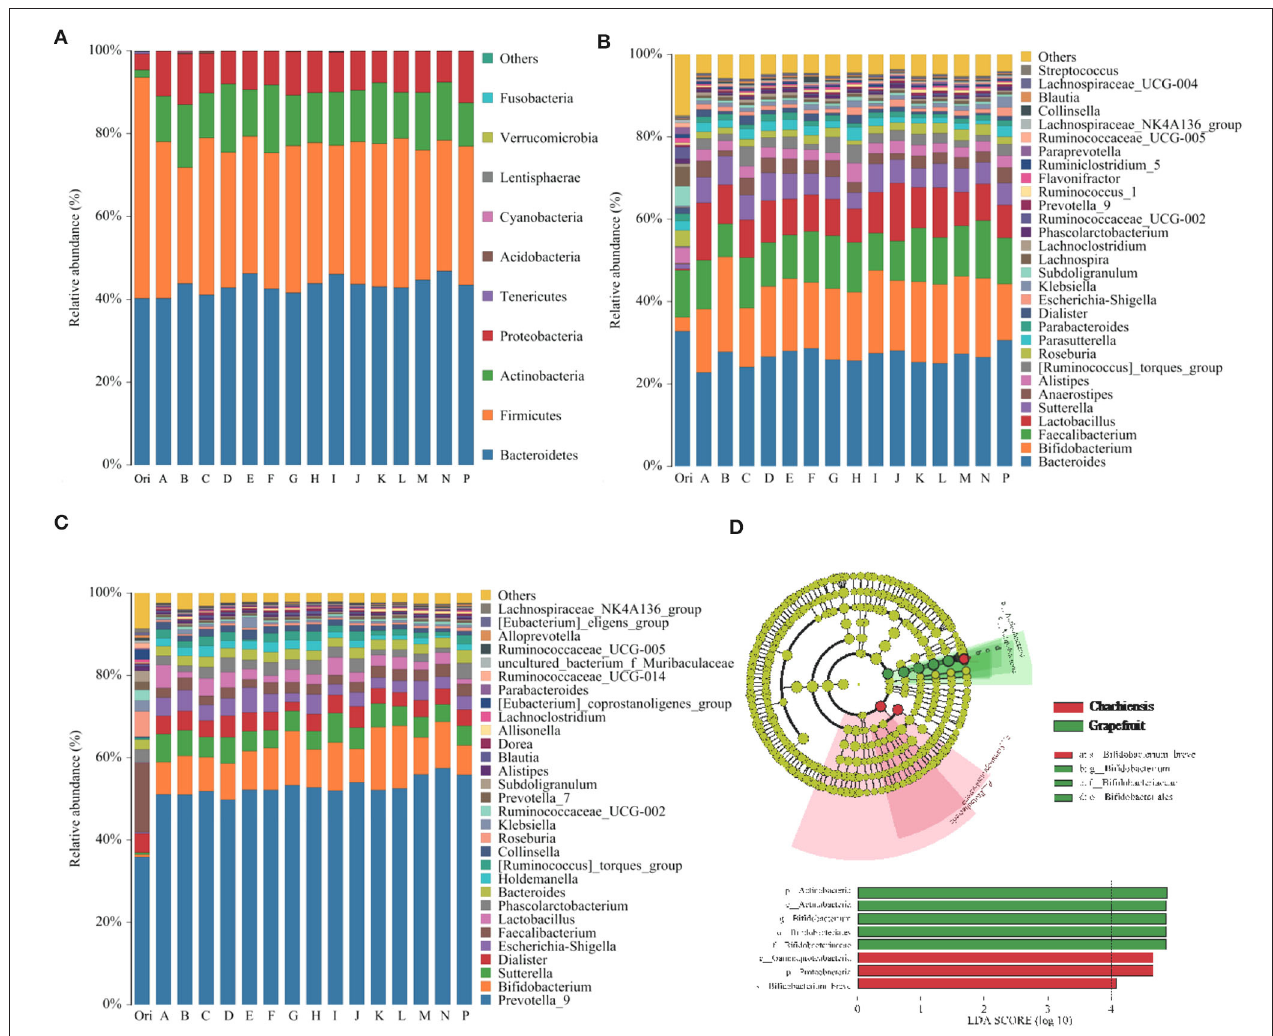
FIGURE 3 | Differences in the distribution and abundance of intestinal microflora in human fecal samples before and after in vitro fermentation with CPFEs. (A) The compositional changes of intestinal microflora at the phylum level ( n = 3); (B) Test subjects with ET B fecal enterotype at the genus level (subject 1, 2 and 5, n = 3); (C) Test subjects with ET P fecal enterotype at the genus level (subject 3, 4, 6 and 7, n = 4); (D) Significant features in microflora of chachiensis and grapefruit CPFEs by LEFSe analysis (LDA > 4.0, P < 0.05). A, satsuma orange; B, chachiensis; C, ponkan; D, lane late navel orange; E, blood orange; F, apple pomelo; G, majia pomelo; H, grapefruit; I, dekopon; J, fertile orange; K, lemon; L, sichuan kumquat; M, longyan kumquat; N, bergamot; P, blank